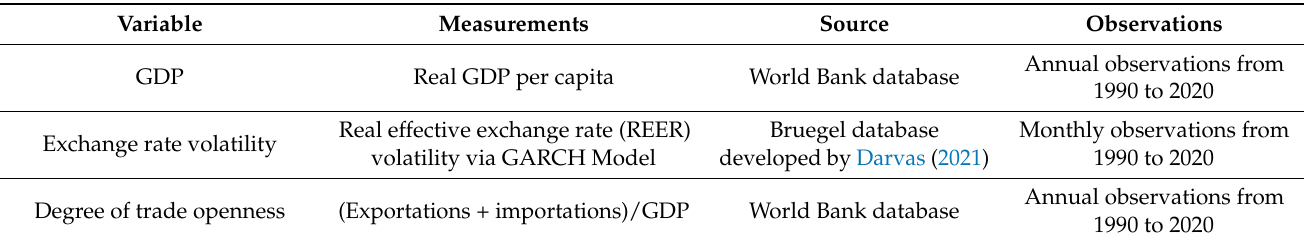
Table 1 below: Table 1. A summary of variables